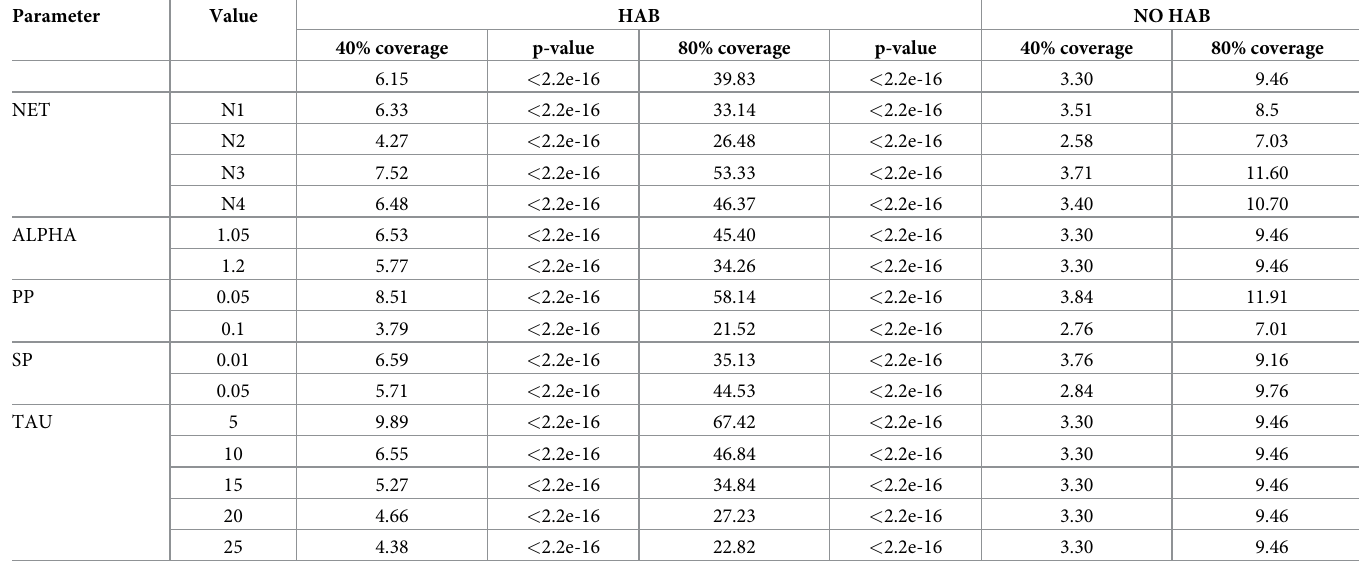
Table 4. Duration for spreading processes with and without